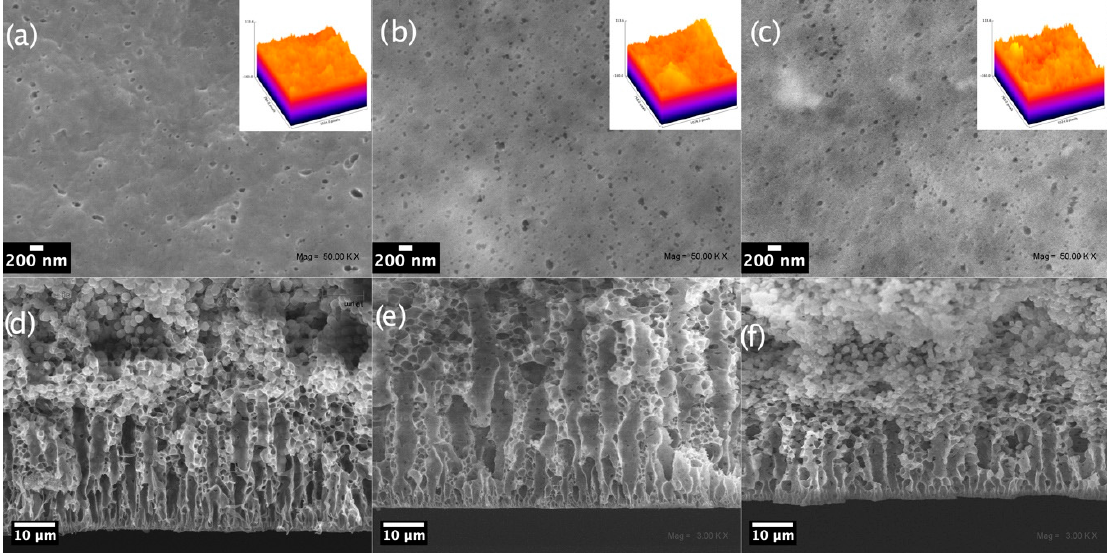
Figure 5. Surface ( a – c ) and cross-section ( d – f ) SEM micrograph images of PVDF composite membranes prepared at 2% ( a , d ), 5% ( b , e ), and 10% ( c , f ) CuONPs. The insets in the upper row show 3D color surface roughness profiles (x = 768 px; y = 1024 px; z (intensity): − 160 to